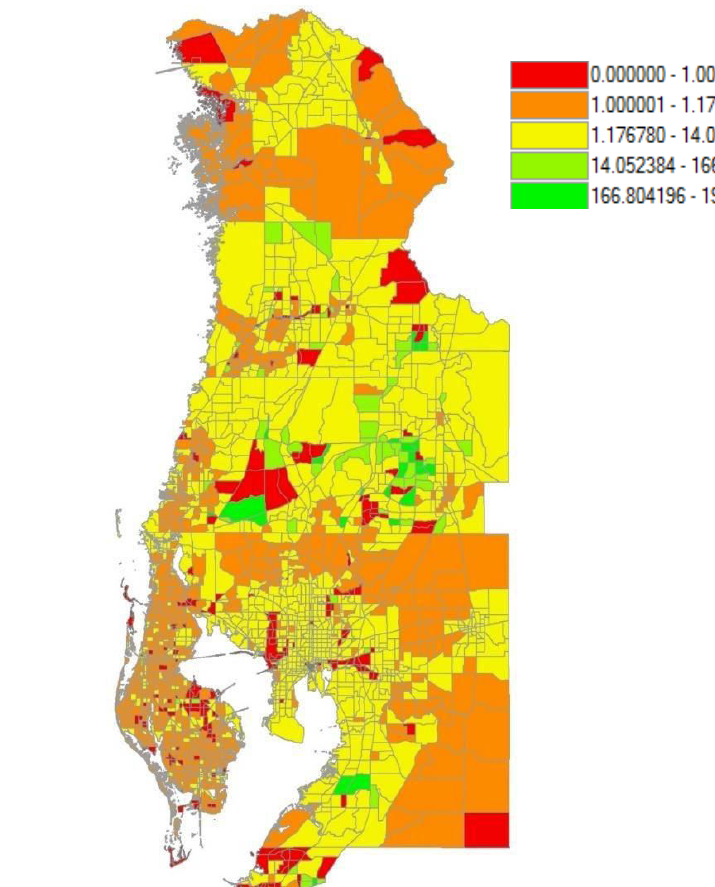
Figure 6 The base growth rate for transportation analysis zones from 2006 to